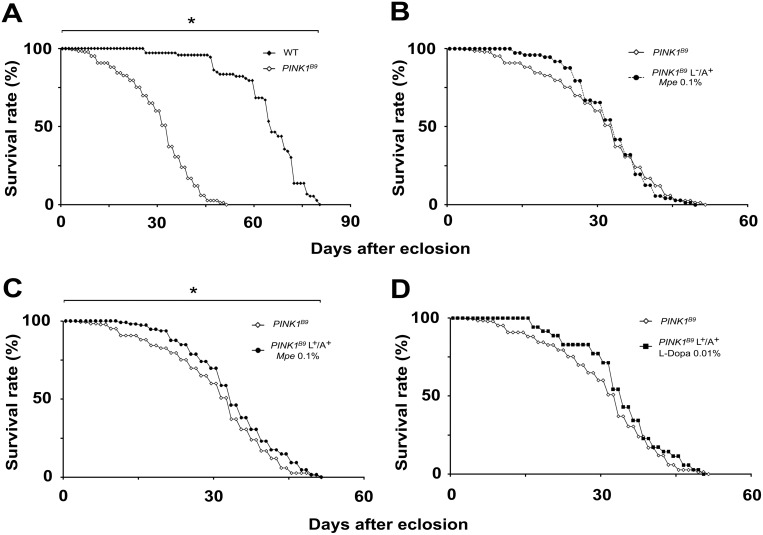
Effects of Mpe and L-Dopa on lifespan.(A): Lifespan, expressed as % survival rates, of wild type (WT) and PINK1B9 flies. (B) and (C): Lifespan of PINK1B9 treated with Mucuna pruriens extract (Mpe) 0.1%,only when adults (L−/A+) (panel B) or from their larval stage to the end of their life-cycle (L+/A+) (panel C), respectively, as compared to lifespan of untreated PINK1B9 flies. (D): Lifespan of PINK1B9 flies treated with L-Dopa (L+/A+) 0.01%. *indicates p<0.05 at Kaplan-Meier survival curves (Gehan-Breslow–Wilcoxon - GraphPad Prism 5.01) between WT and untreated PINK1B9 (A) and between untreated PINK1B9 and PINK1B9 fed Mpe 0.1% (C).